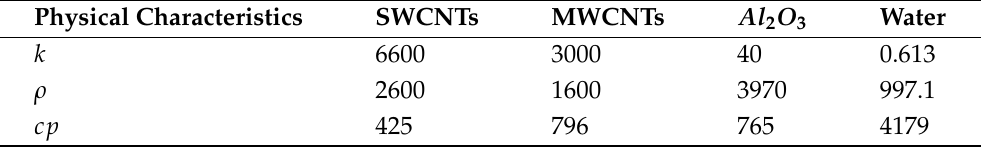
Table 1. Physical properties.